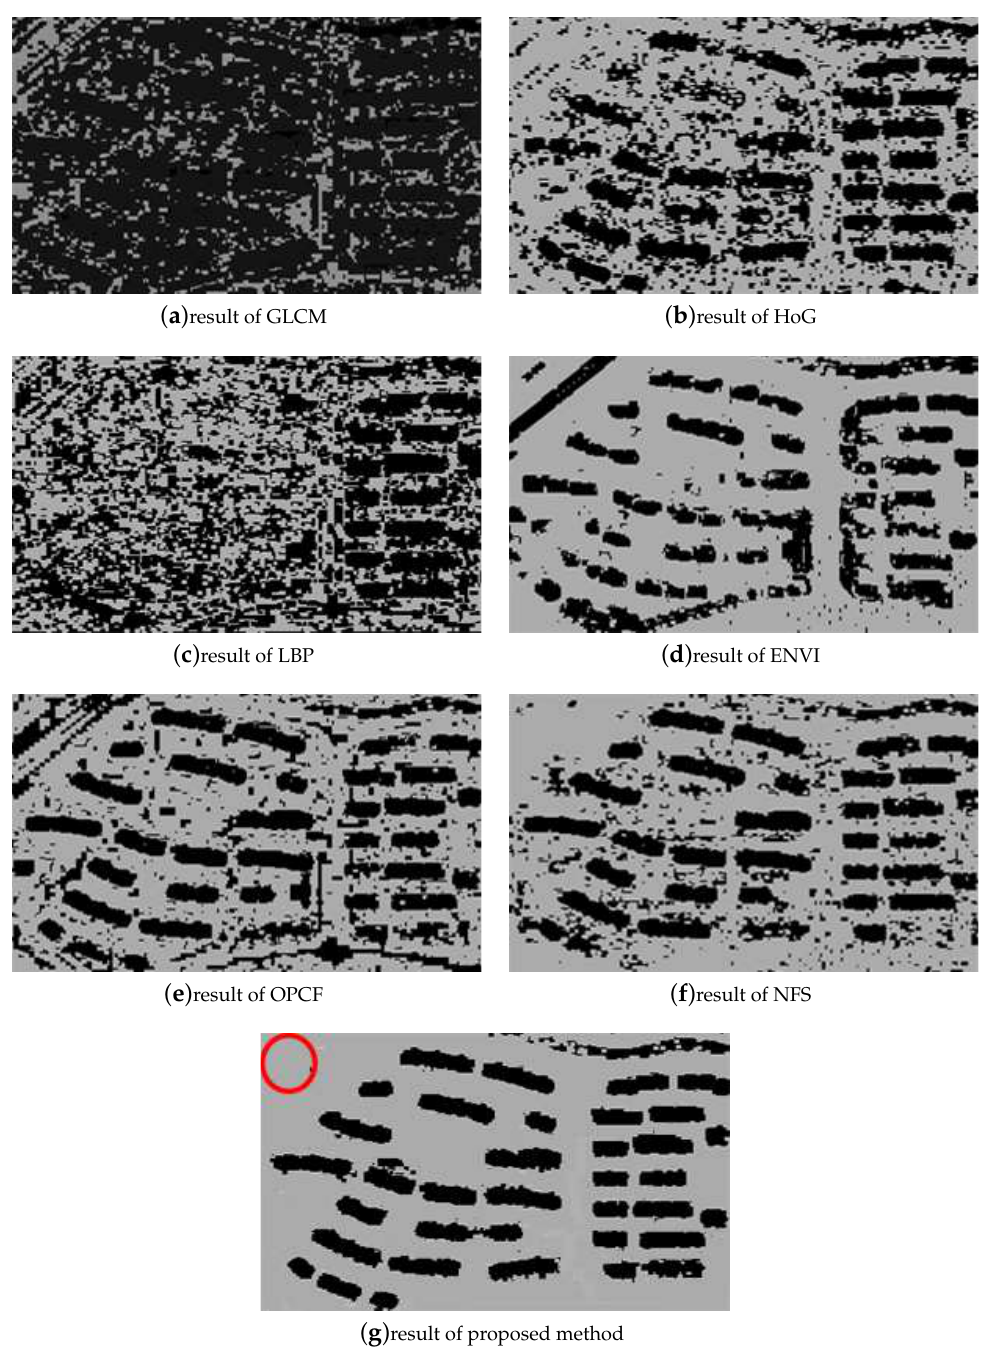
Figure 10. Building extraction results of LDR